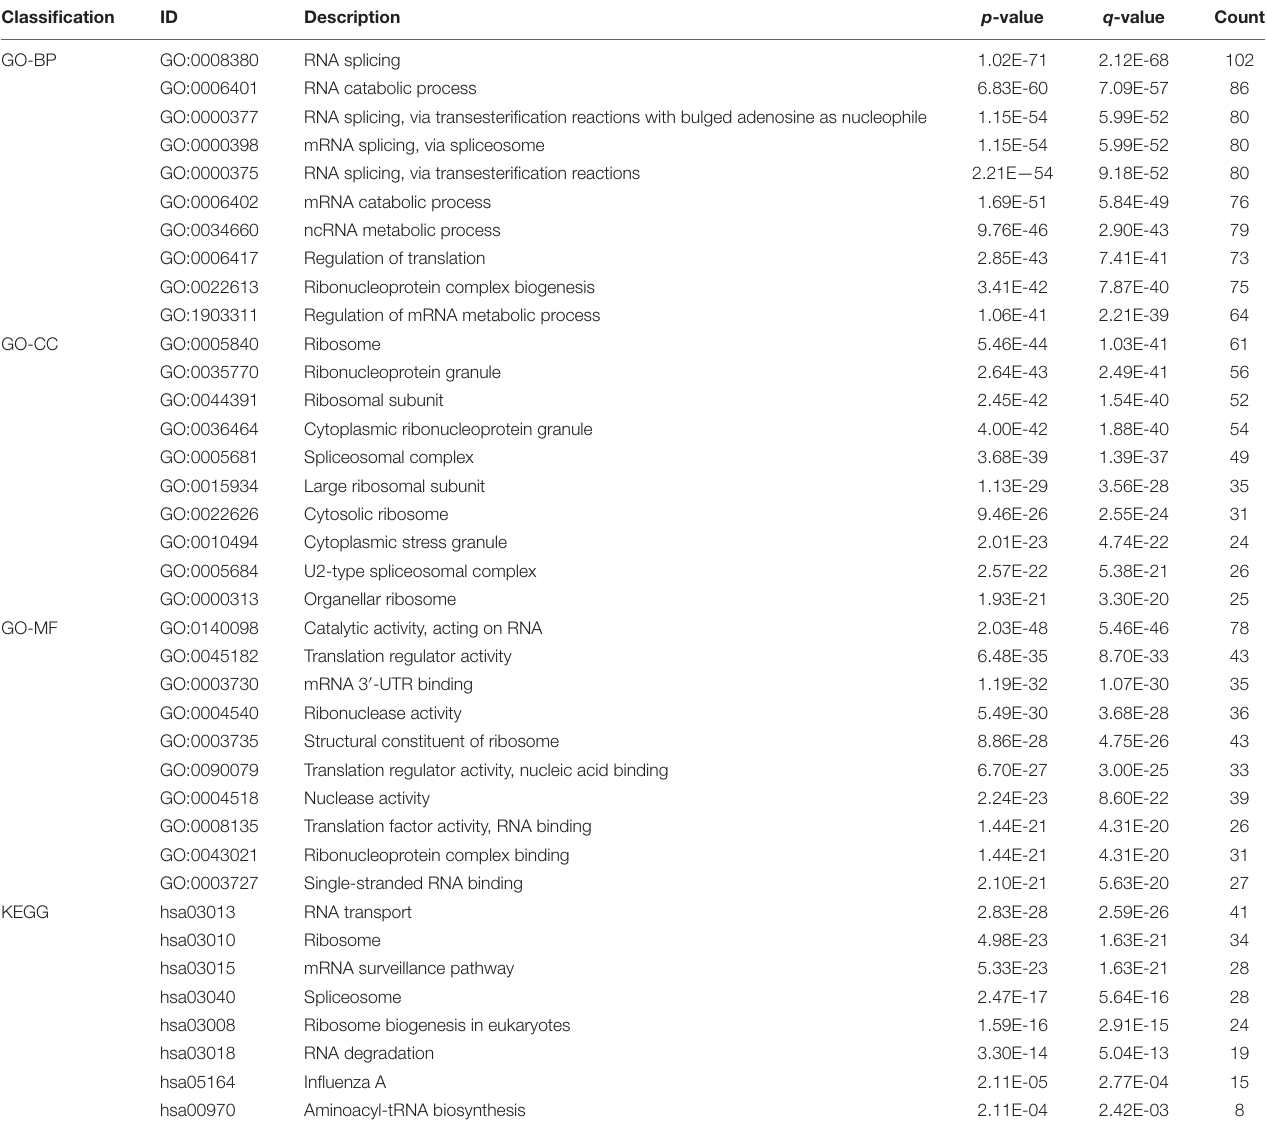
TABLE 2A | GO and KEGG functional enrichment analysis of differential expression –RBPs (DE-RBPs) in PAAD.